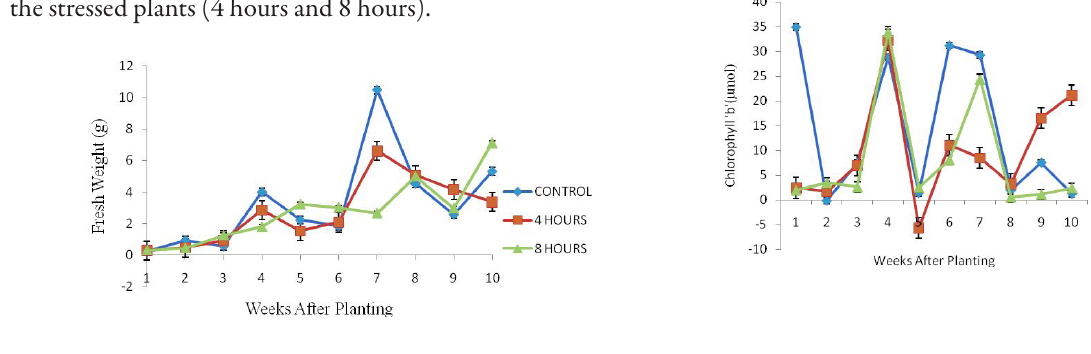
Fig. 3. Effect of prior heat stress on the fresh weight of C. pa- paya